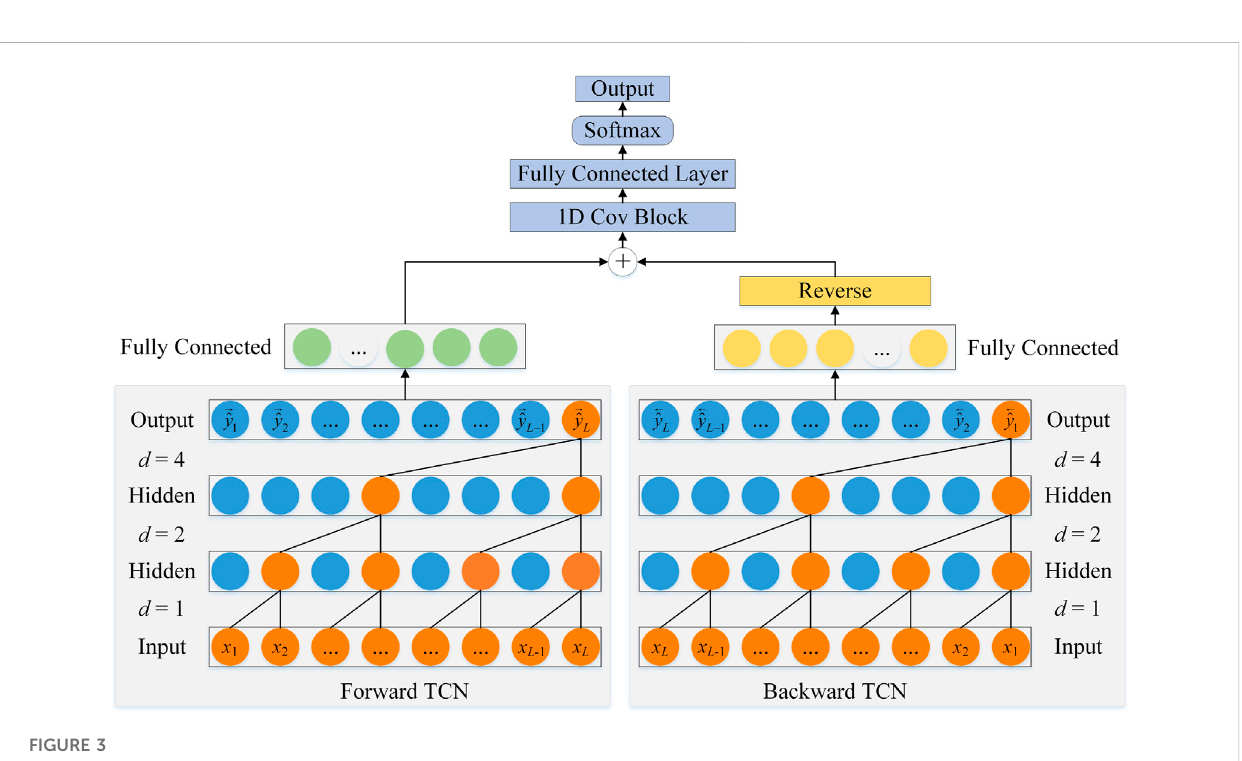
FIGURE 3 The architecture of